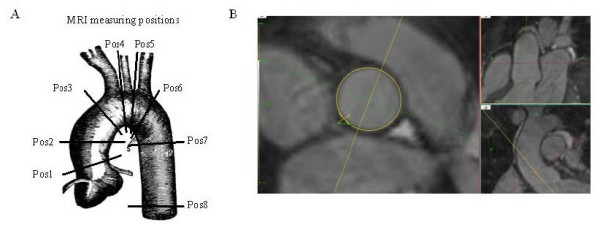
CMR measuring positions, where pos1, pos3 and pos 6 were also measured by echocardiography. Post-processing of 3D isotropic CMR in positon 1 of the ascending aorta, at sinotubular level. It illustrates the ability to ensure precise and reproducible measurement of aortic diameter, where accuracy is ensured by the use of 3 separate planes placed perpendicular to each other and the aortic wall at the position of measuremtn.